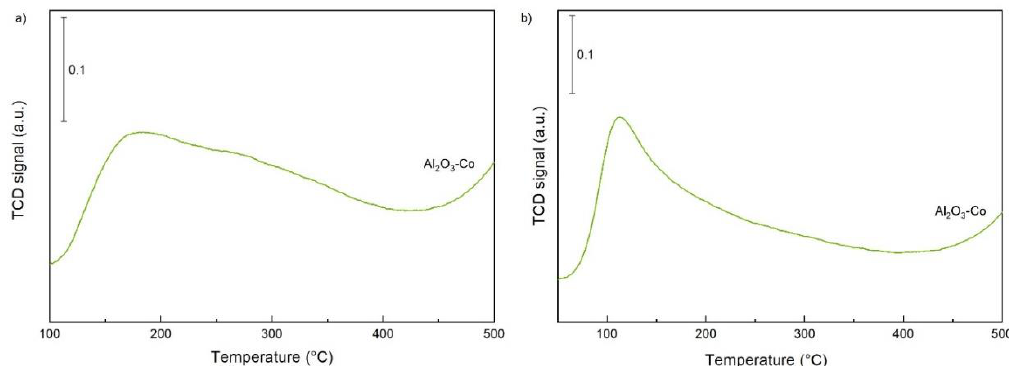
Figure A4. Acidity ( a ) and basicity ( b ) of Al 2 O 3 cobalt catalyst determined by NH 3 -TPD and CO 2 -TPD, respectively.